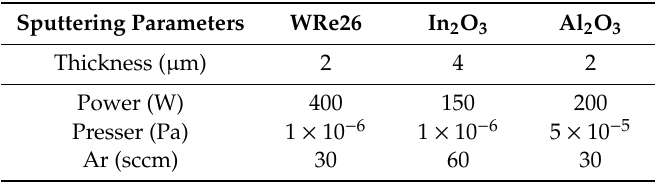
Table 1. Sputtering parameters of WRe26-In2O3